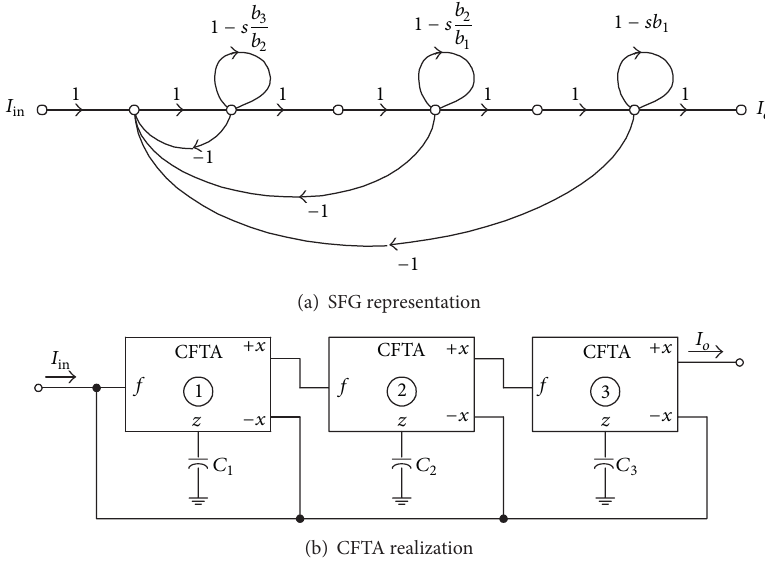
Figure 8: Third-order all-pole lowpass Butterworth current transfer